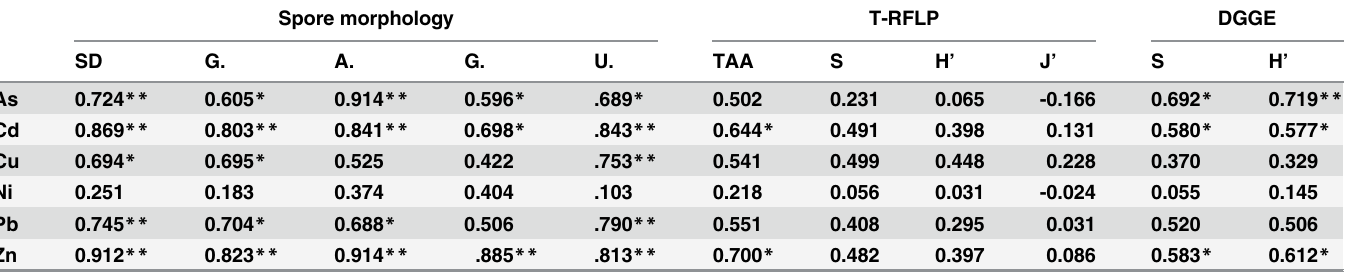
Table 2. Pearson correlation coefficient between soil heavy metals and metalloid, spore count, T-RFLP and DGGE of arbuscular mycorrhizal fungi. Spore